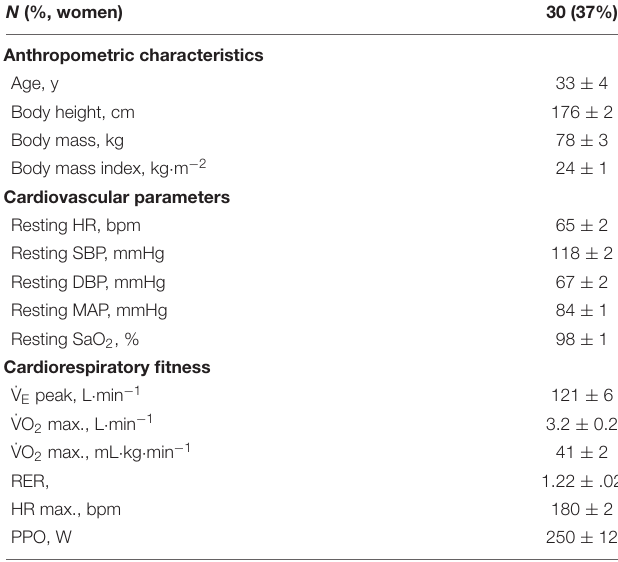
TABLE 1 | Participants